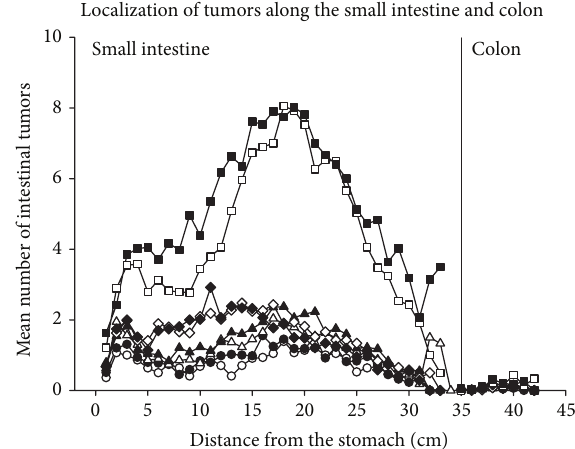
Figure11:Localizationoftumorsalongthesmallintestineandcolon for pooled female and male Min/+ mice; 10+10+10 ( I ), 45+10+10 ( e ), 10+45+10 ( △ ), 45+45+10 ( 󳵳 ), 10+10+45 ( ◊ ) and 45+45+45 ( X ), and the PhIP-exposed groups; 45+45+10 ( ◻ ), and 45+45+45 ( ◼ ). The tumor position is given as distance from the stomach measured in cm. The experimental groups are as explained in the legend to Figure 1. 𝑛 = 44 – 65